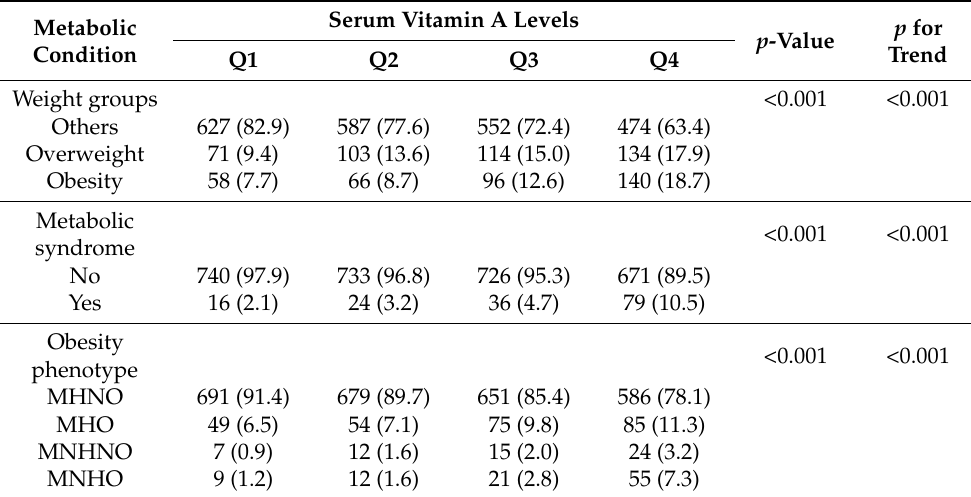
Table 2. Prevalence of metabolic disease conditions across serum vitamin A quartiles in children and